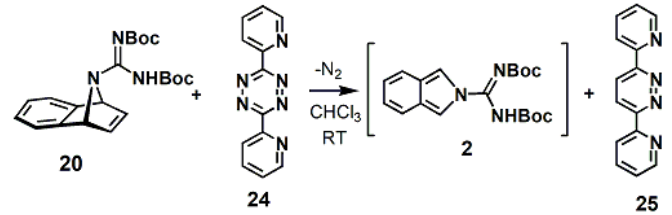
Scheme 3. Generation of isoindole 2 using tetrazine method.